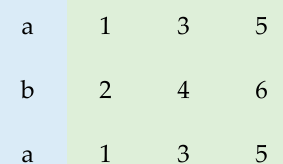
Figure 9. State transition diagram and state transition probability matrix when absorbing state 0 is introduced ( n = 9).